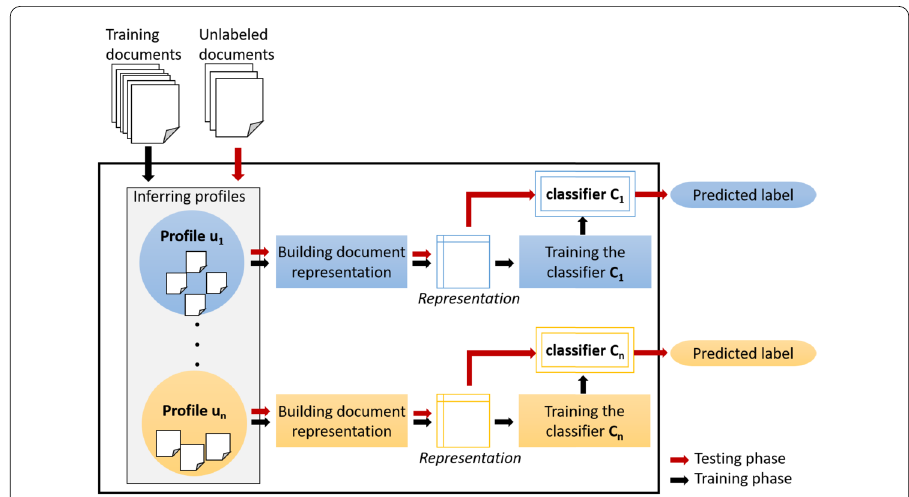
Figure 1 General approach for depression detection using specialized classifiers for the different users’